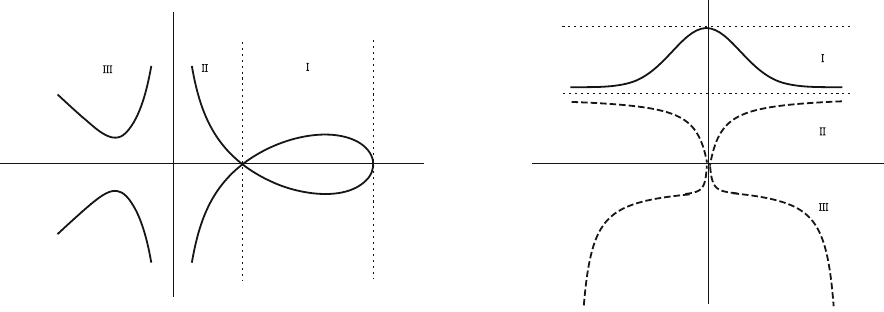
Figure 8: The graphs of the phase - portrait and the wave pro fi le when ( ) P ϕ has a double positive root, one positive root and two conjugate complex